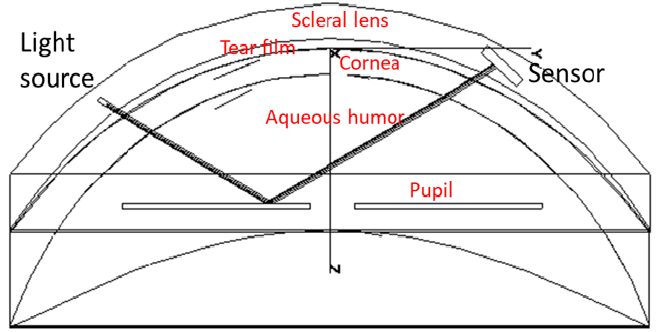
Figure 2. Datacom-based solution: ray-tracing taking into account the different optical interfaces.